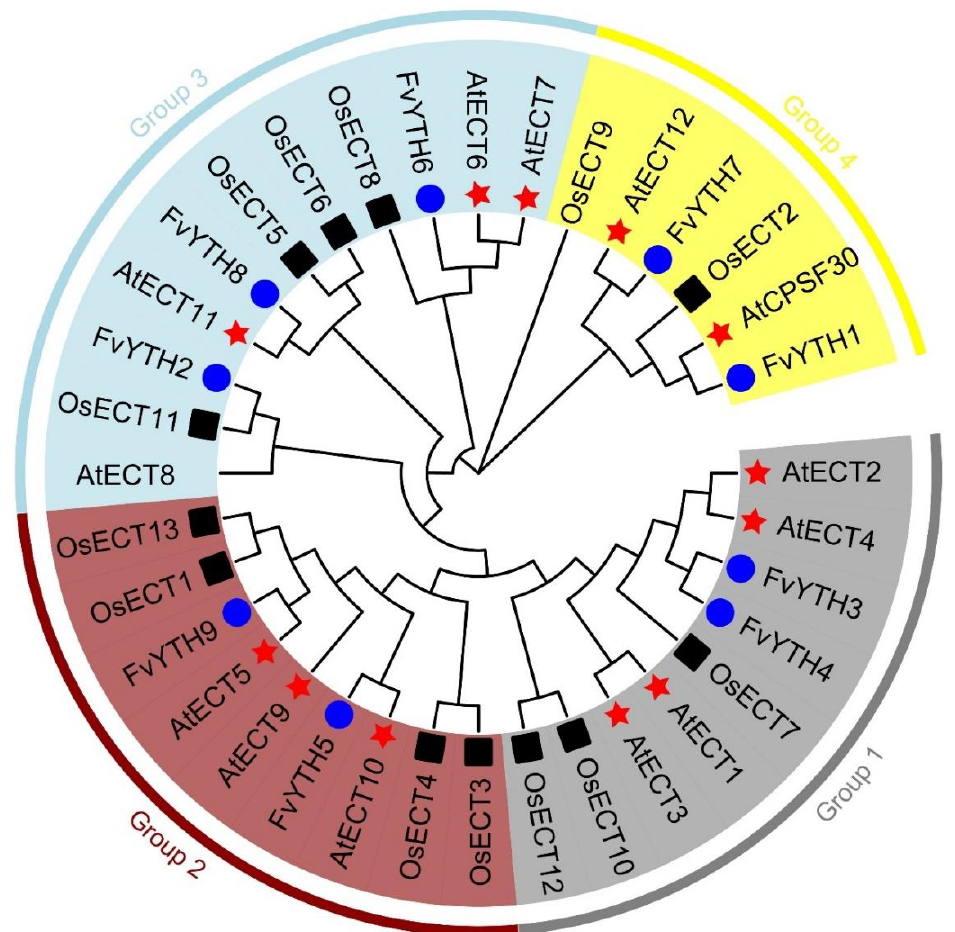
Figure 4. Phylogenetic analysis of YTHs in strawberry, rice, and Arabidopsis . The sequences of YTH domain from strawberry, rice, and Arabidopsis were used to construct a phylogenetic tree by NJ method, with 1000 bootstrap replications. Red stars represent Arabidopsis , blue circles represent rice, and black boxes represent strawberry.